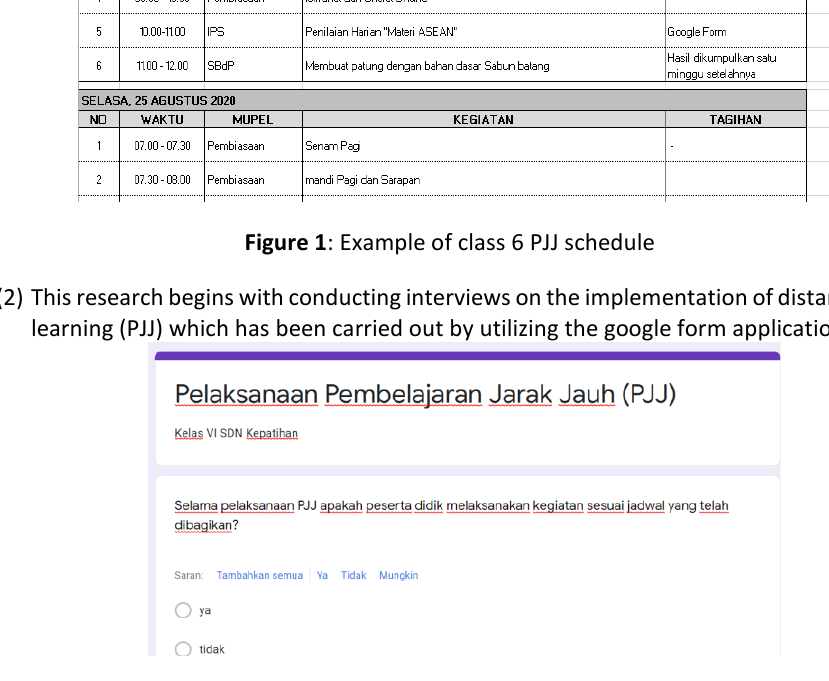
Figure 2 : Observation using google